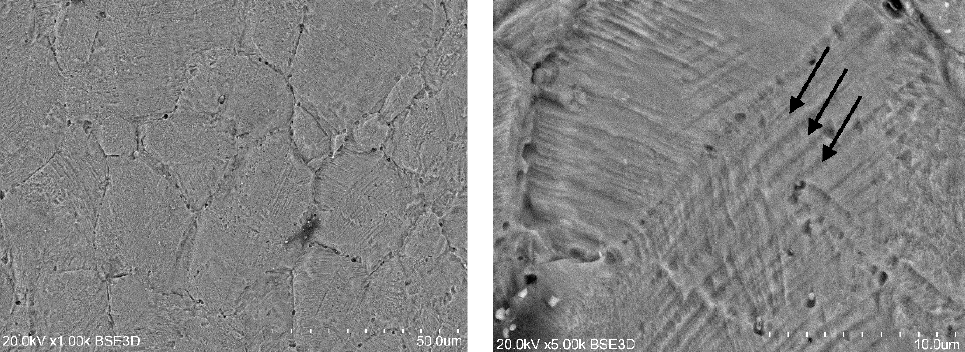
Figure 1. Structural-phase state of the Co-Ni-Nb alloy: ( left side ) initial sample microstructure and ( right side ) fragment microstructure with twins (black arrows).